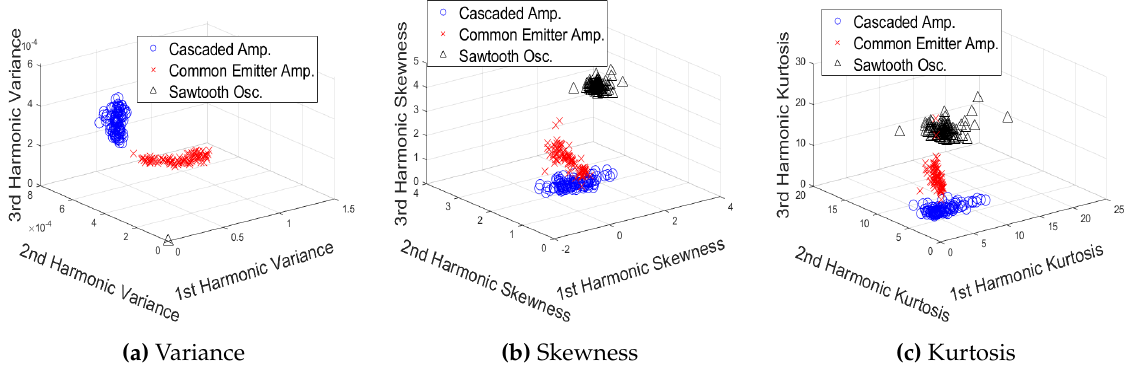
Table 1. Confusion matrices for statistical features in first, second, and third harmonic space for SNR=8 dB.